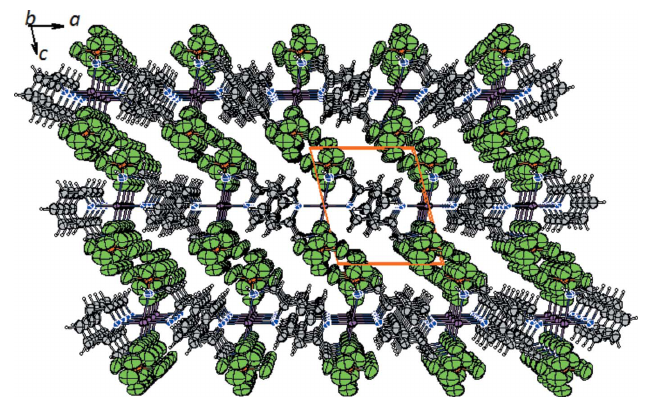
Figure 2 The crystal packing of the title salt, viewed along the b axis. Orange solid lines indicate the unit cell.